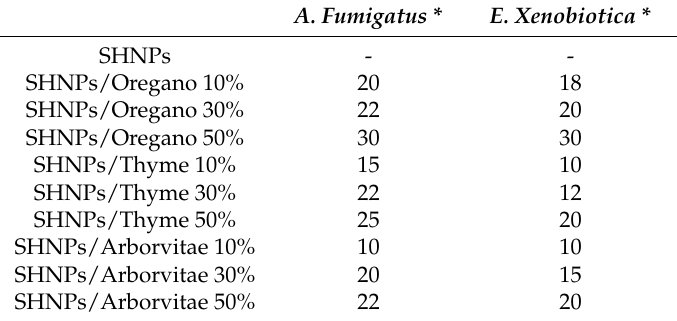
Table 1. Antifungal activity of different combinations of EOs and